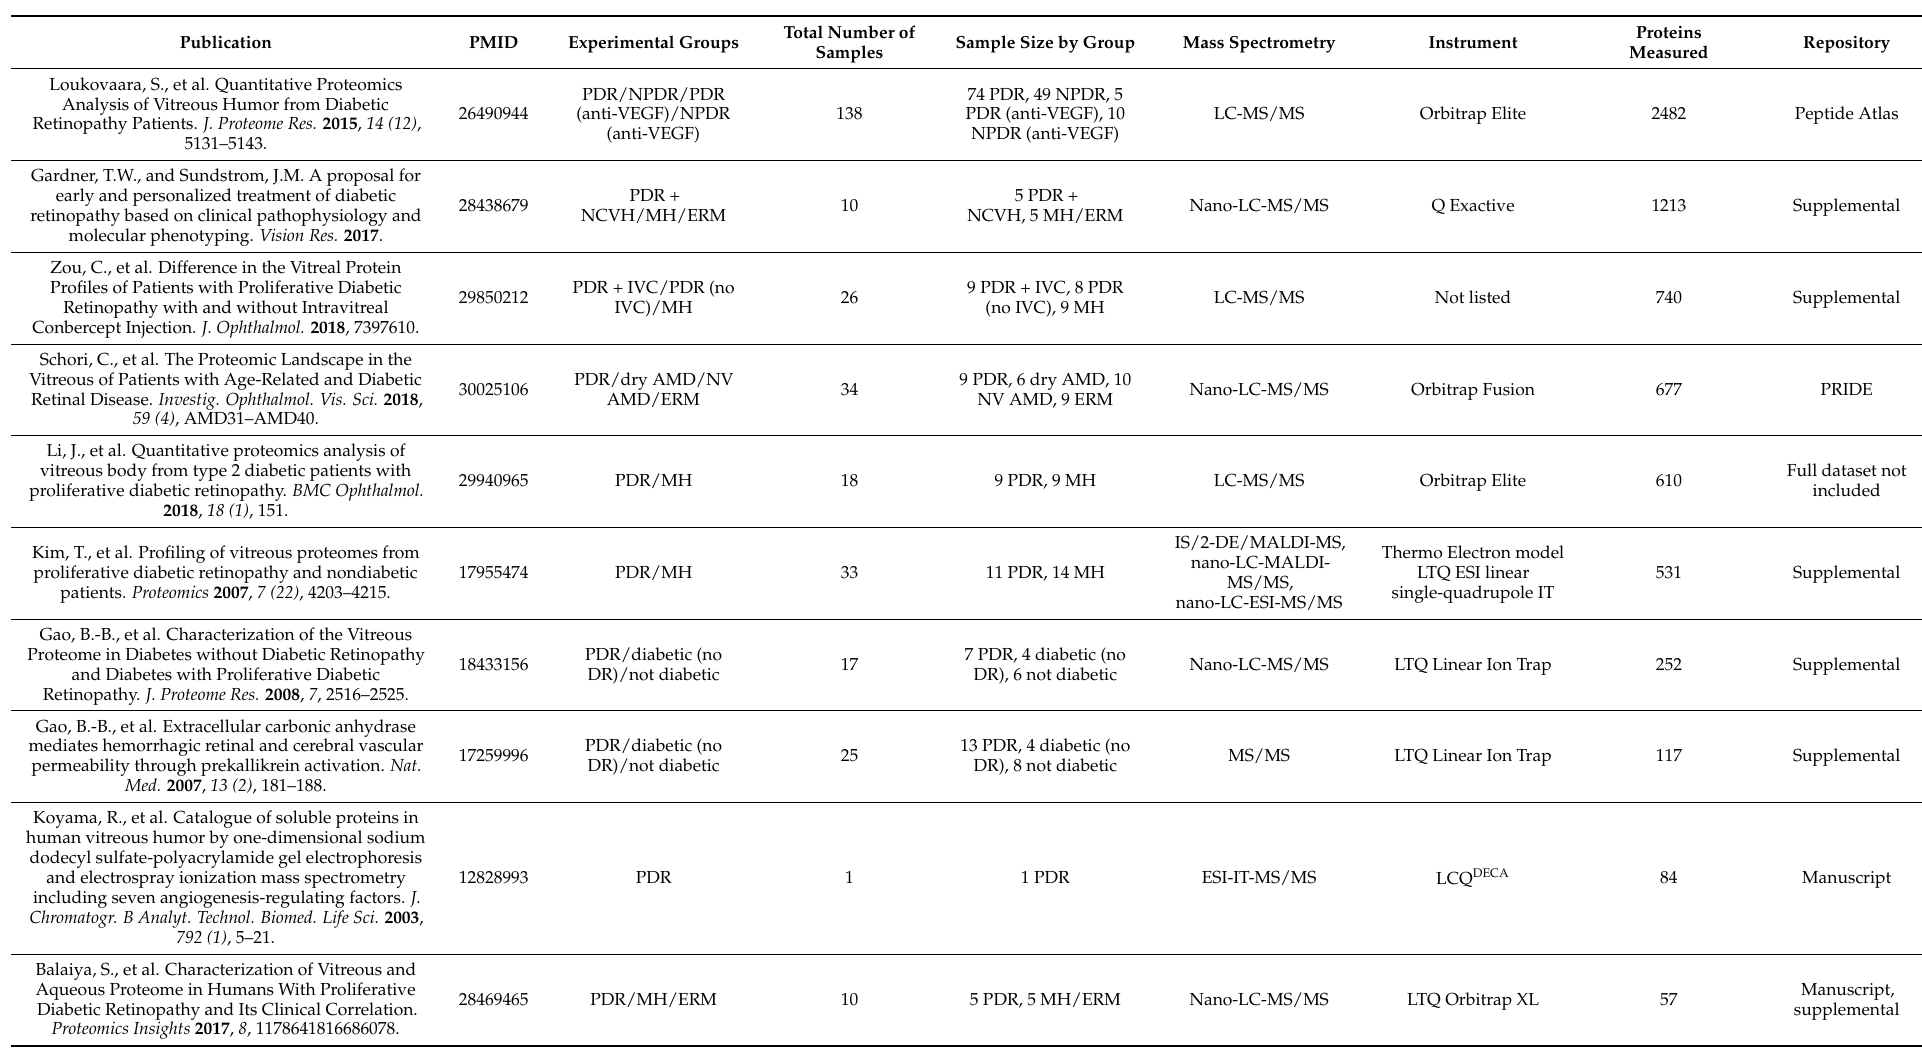
Table 1. Summary of prior mass spectrometry-based proteomic studies of a proliferative diabetic retinopathy vitreous. Experimental details of the studies described in the text are outlined here in order from the highest to the lowest number of proteins